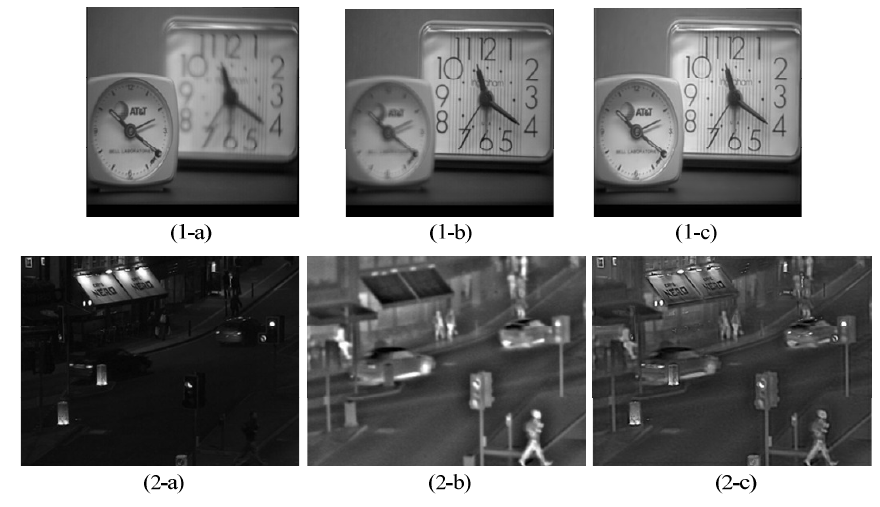
Figure 10. Multi-focus and Infrared-visible Image Fusion Results of Proposed Solution, (1-a) and (1-b) are the multi-focus source images, (1-c) is the fused image by our proposed solution, (2-a) and (2-b) are the infrared-visible source images, and (2-c) is is the fused image by our proposed